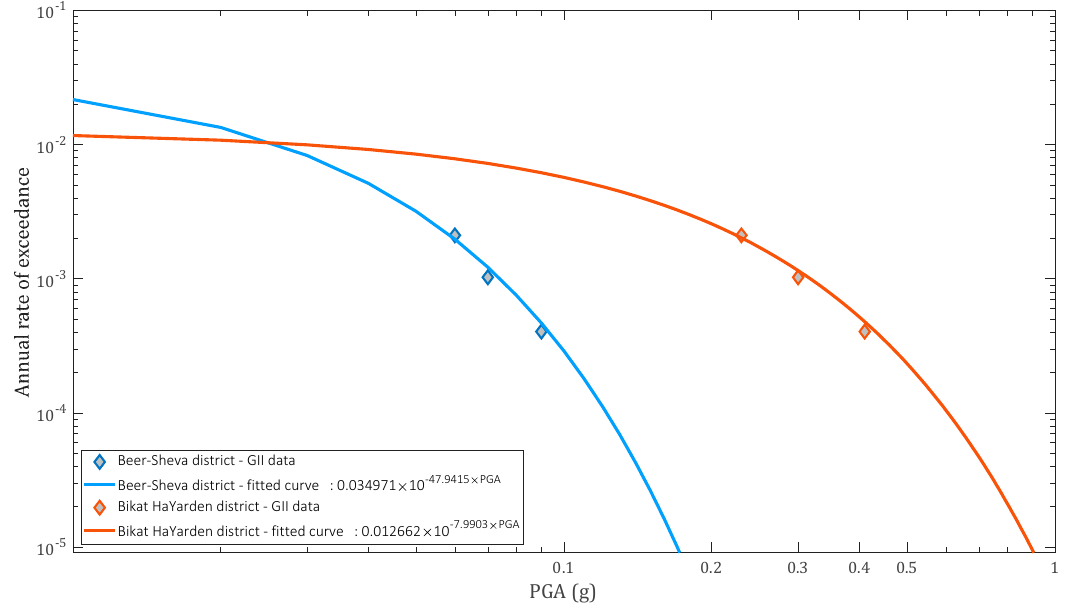
Figure 3. Hazard curve for Be’er Sheva and Bik’at HaYarden regions.